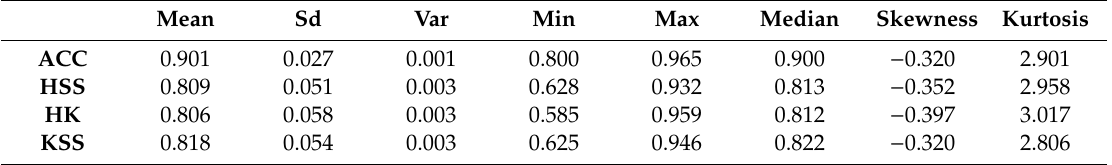
Table 4. Statistics for the scores of the K -nearest Neighbors (KNN) method ( K = 1).